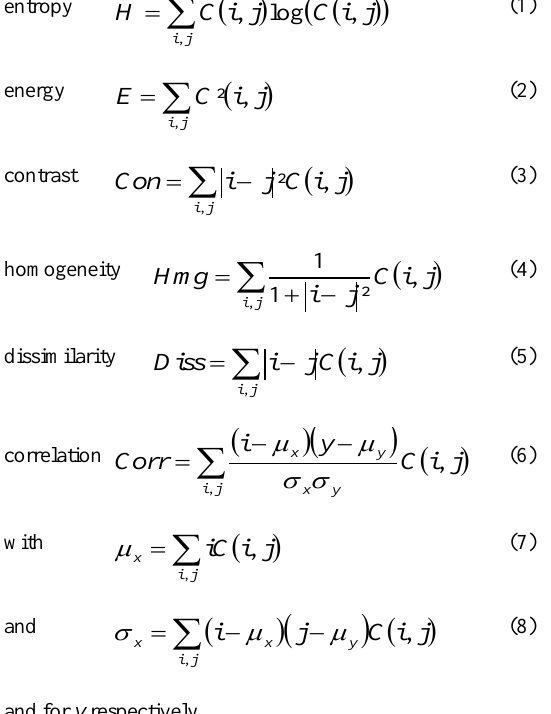
Figure 1 outlines the data flow of our processor.